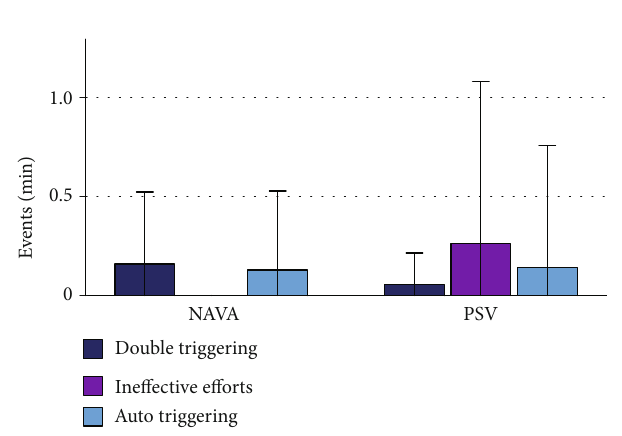
Figure 2: Frequency of asynchrony sorted by type; modes contrasted. Di ff erences showed statistical signi fi cance for double triggering ( p = 0 : 02 ) and ine ff ective e ff orts ( p = 0 : 001 ), but not for auto triggering ( p = 0 : 584